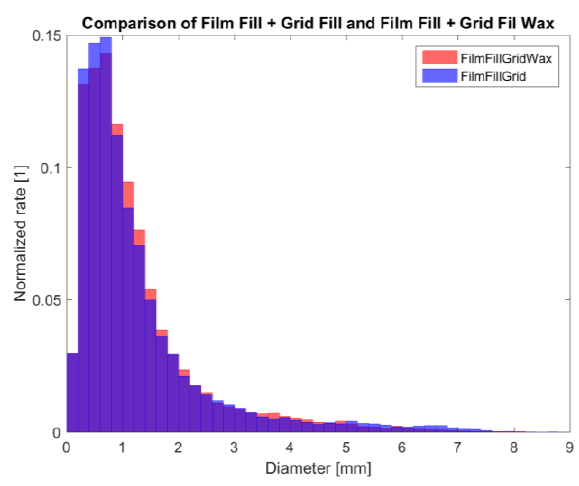
Fig. 14. Histogram of comparison combinations of film fill and grid fill with wax and fill and grid fill without surface treatment .